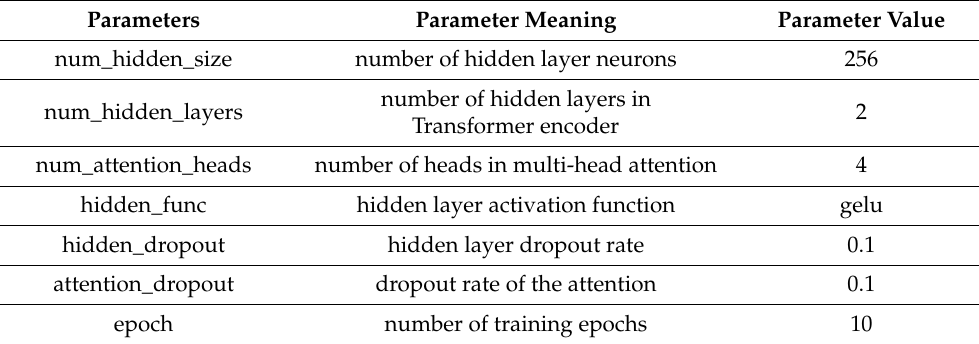
Table 5. The parameters of